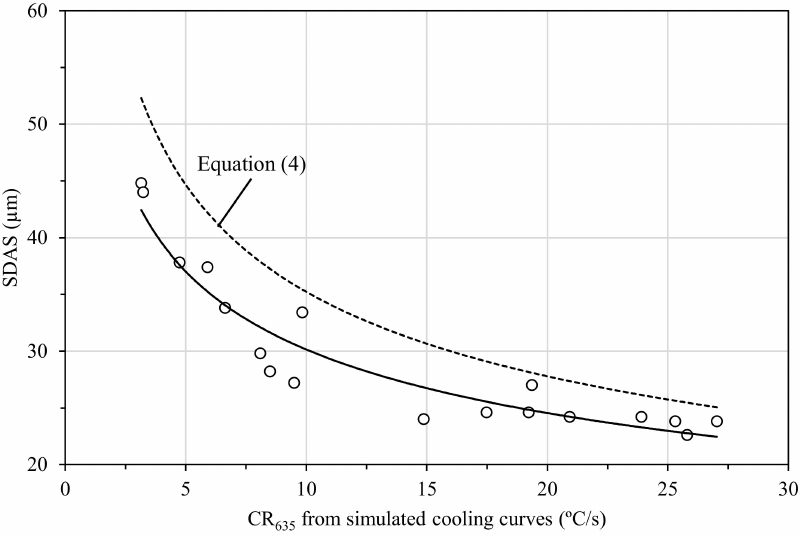
Figure 9. Evolution of experimental and calculated SDAS in the SK-1 to SK-6 castings with CR 635 parameter. Table 7. Individual values of the solidification parameters determined from the simulated cooling curves obtained in the areas of castings SK-7 and SK-8.